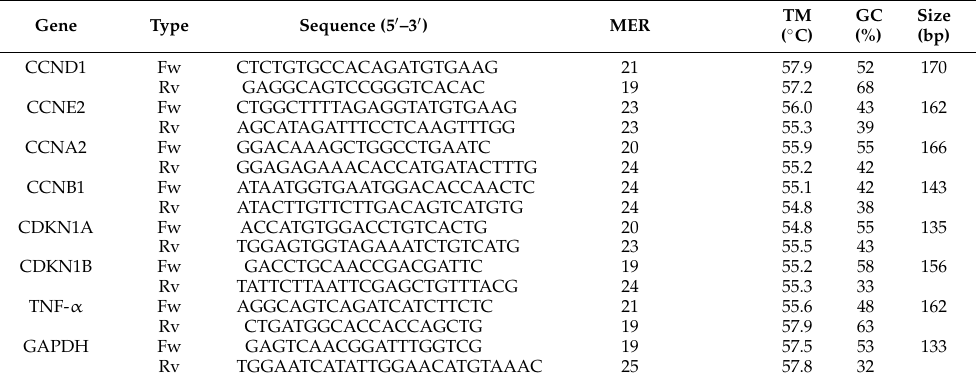
Table 2. Primers used for